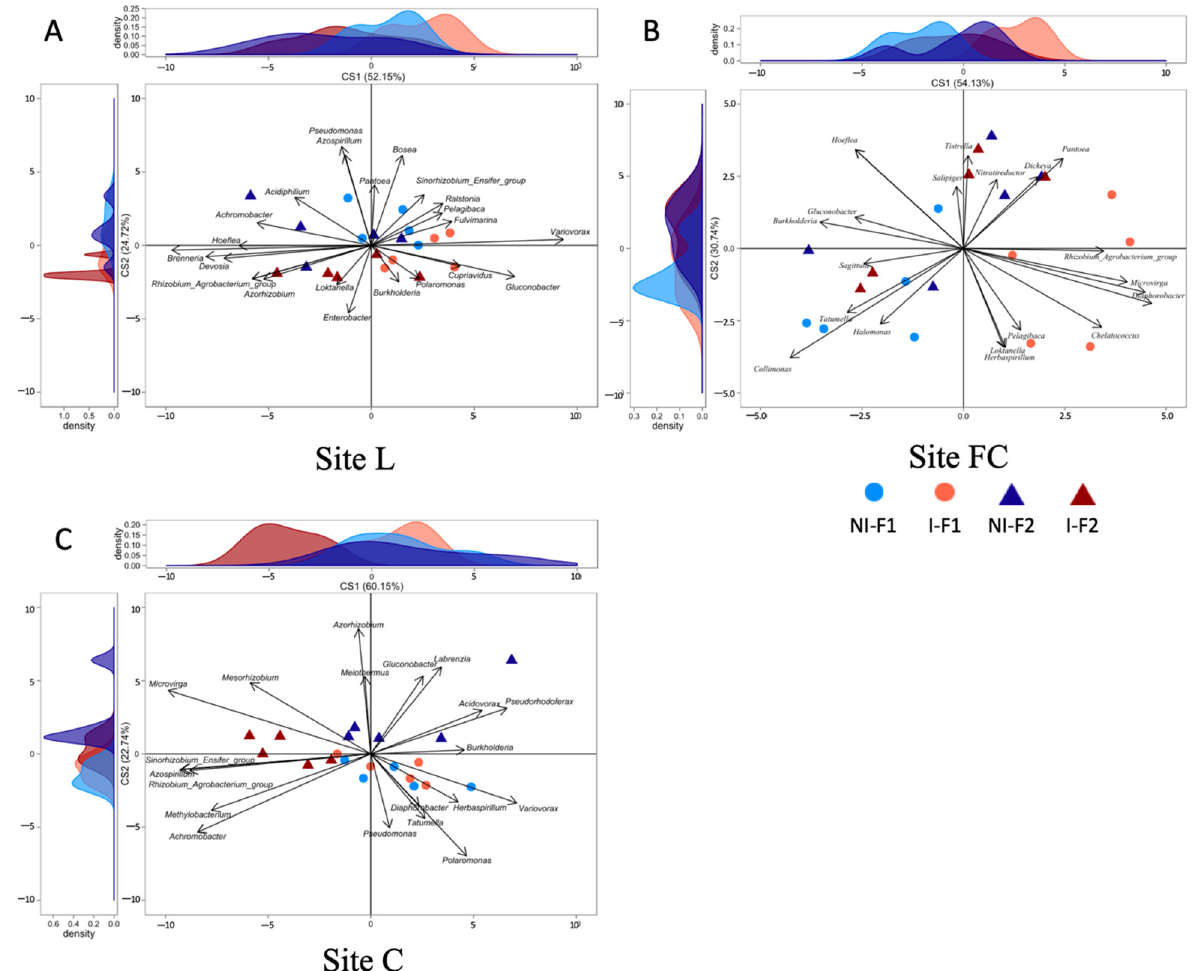
Figure 3. Effect of inoculation level of A. lipoferum CRT1 on the composition of the ACC deaminase producers ( acdS ) as indicated by between-class analyses (BCA) studied at three field sites L ( A ), FC ( B ), and C ( C ). F1 (circles) corresponds to the peat matrix used to coat seeds with low inoculant concentration, using data originating from [21], and in F2 (triangles), A. lipoferum CRT1 was used at higher inoculant concentration. NI (blue) and I (reddish) correspond, respectively, to non-inoculated and inoculated conditions. Curves on top and left represent, respectively, the sample distribution on abscissa and ordinate axes. Vectors on plot represent the bacterial genera contributing the most to sample distribution.